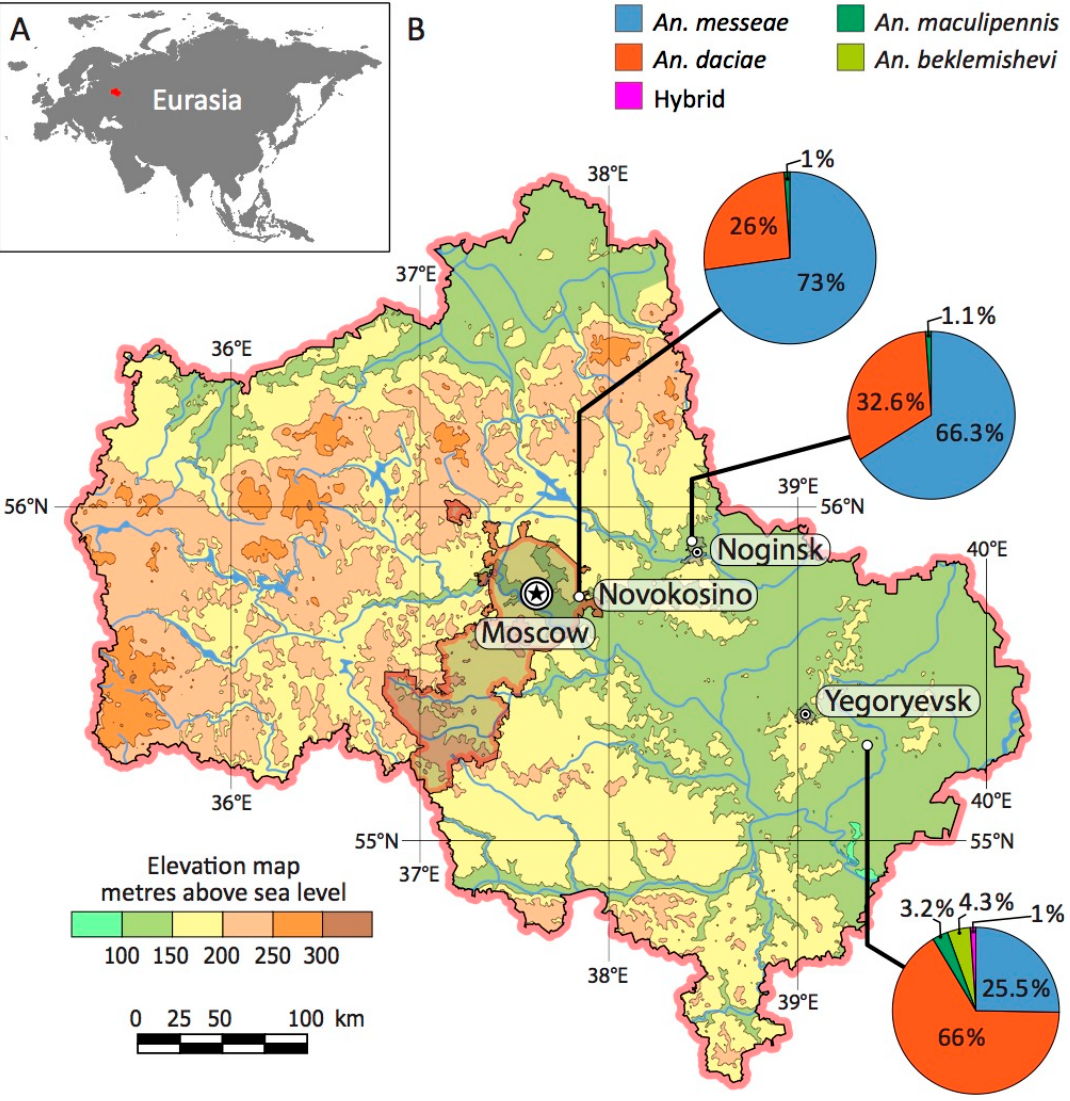
Figure 1. Location of the Moscow region in Eurasia ( A ) and collection sites of mosquito larvae ( B ). The ratios of An. messeae , An. daciae , their hybrids, An. maculipennis , and An. beklemishevi are shown as pie charts for each population. The charts show different proportions of the species in three compared populations. The map was developed using OpenStreetMap data [59].